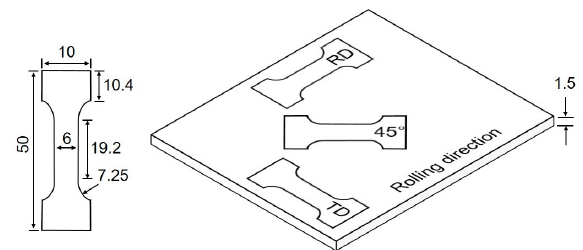
Figure 4. Specimen dimensions and orientations in respect to the sheet rolling